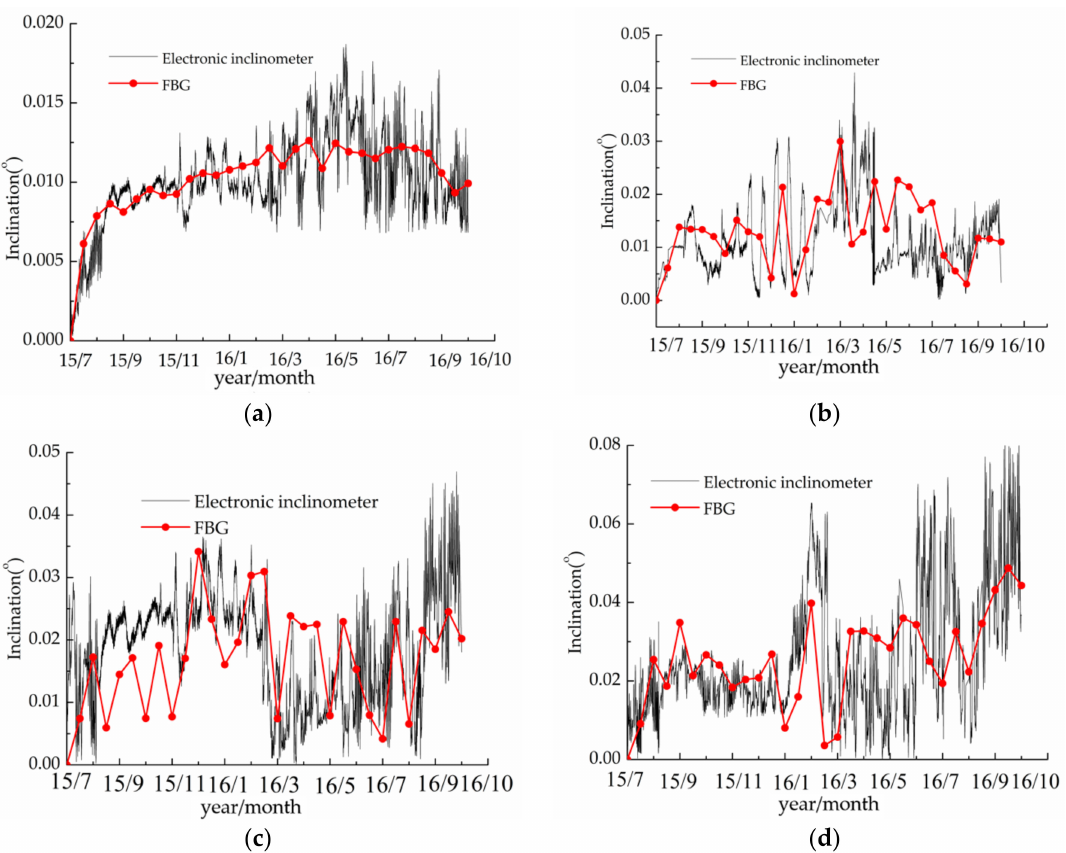
Figure 12. ( a – d ) respectively indicate column Z1, Z4, Z5, and Z8 inclination angle comparison